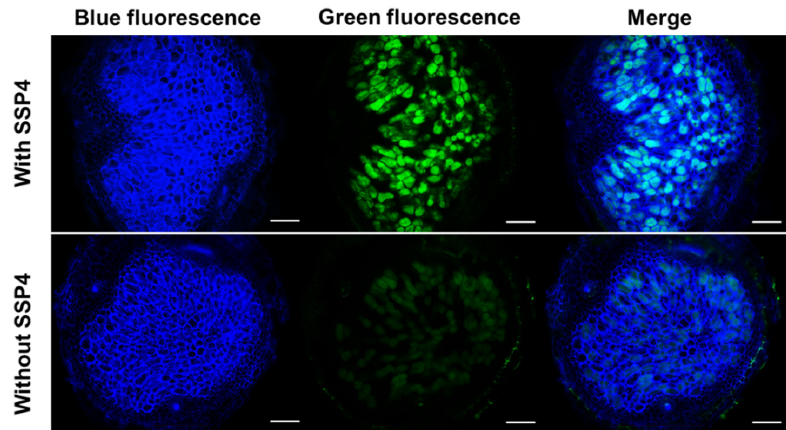
Figure 4. Detection of reactive sulfur species in nodules. Blue fluorescence indicates nodule cell walls stained with calcofluor white. Green fluorescence indicates RSS labeled with SSP4. The green fluorescence of without SSP4 shows autofluorescence. L. japonicus B-129 was used as a host plant. Scale bars, 100 μ m.